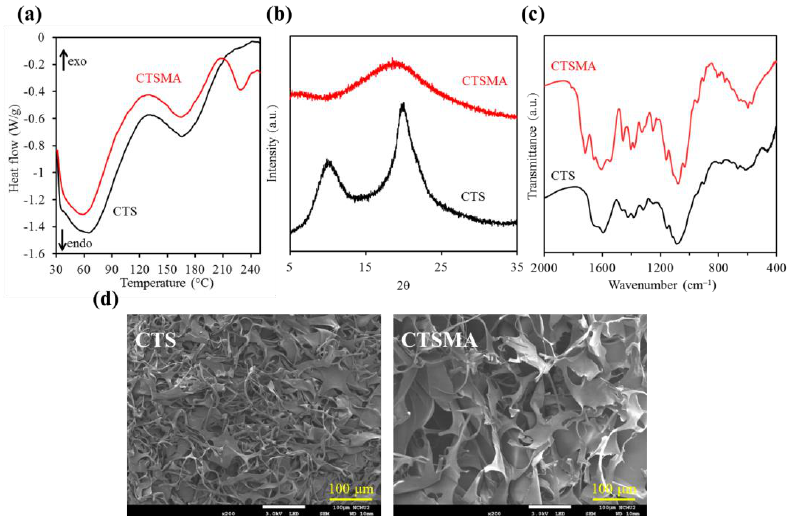
Figure 2. ( a ) DSC analyses, ( b ) XRD patterns, ( c ) FTIR spectra, and ( d ) SEM images of chitosan (CTS) and methacrylated chitosan (CTSMA) powders.